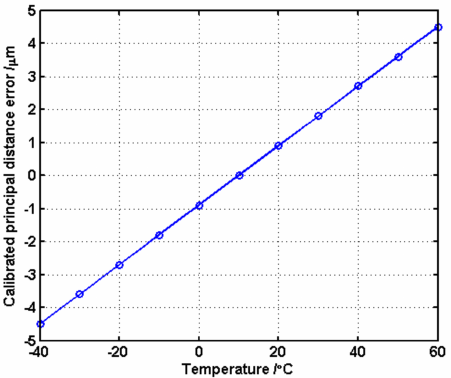
Figure 5. The calibrated principal distance error at different